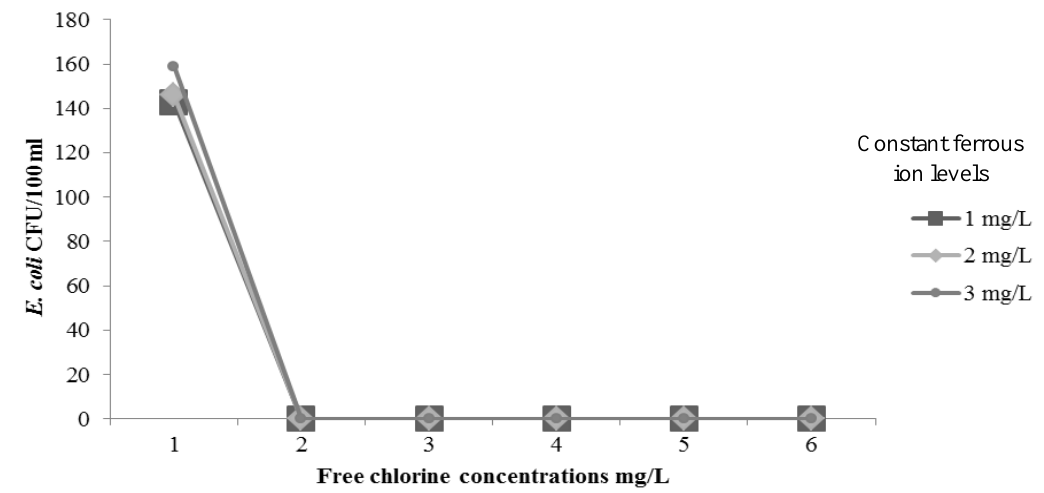
Figure 3: Inhibition of E.coli at different Cl 2 concentrations under constant ferrous ions concentrations of 1, 2 and 3